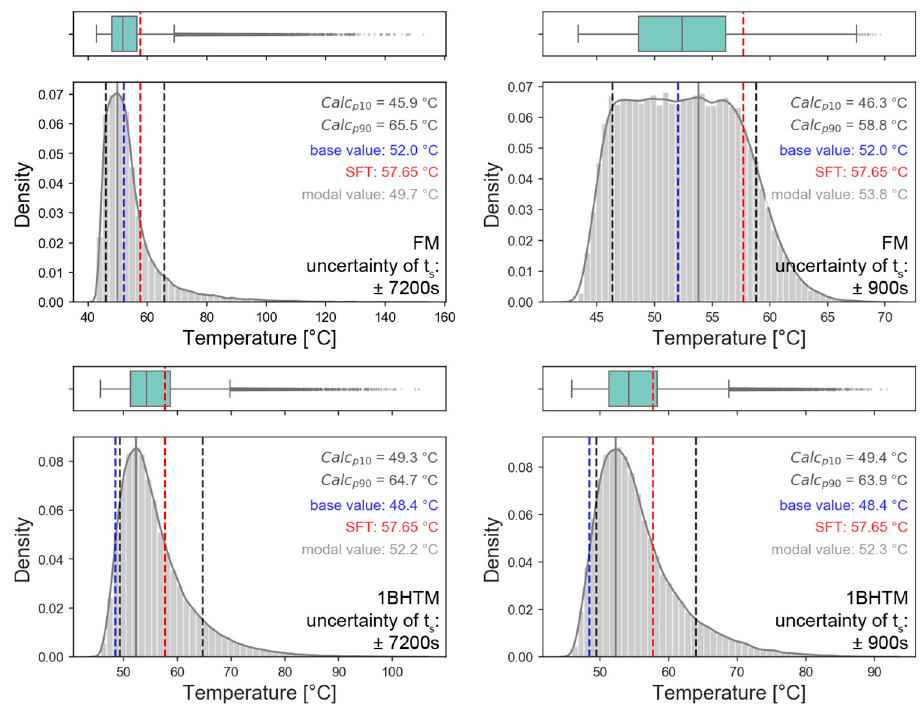
Figure 16. Distribution of solution after running Saltelli sampled FM (top) and 1BHTM (bottom) at high uncertainty of shut-in time with applied variance of ± 7200 s (left) and high confidence with applied variance of ± 900 s (right).